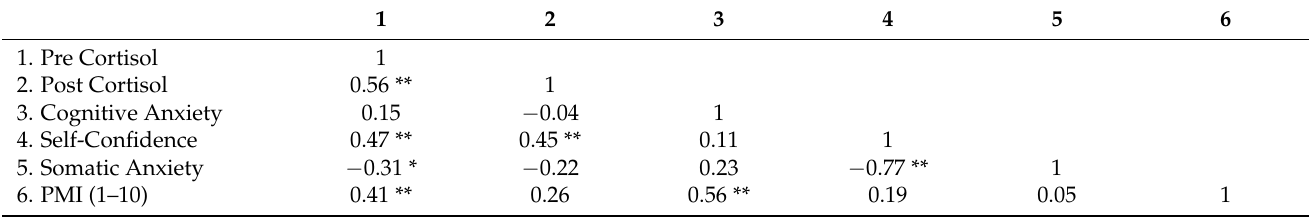
Table 2. Correlation matrix for cortisol, cognitive anxiety, somatic anxiety, self-confidence, and perceived game